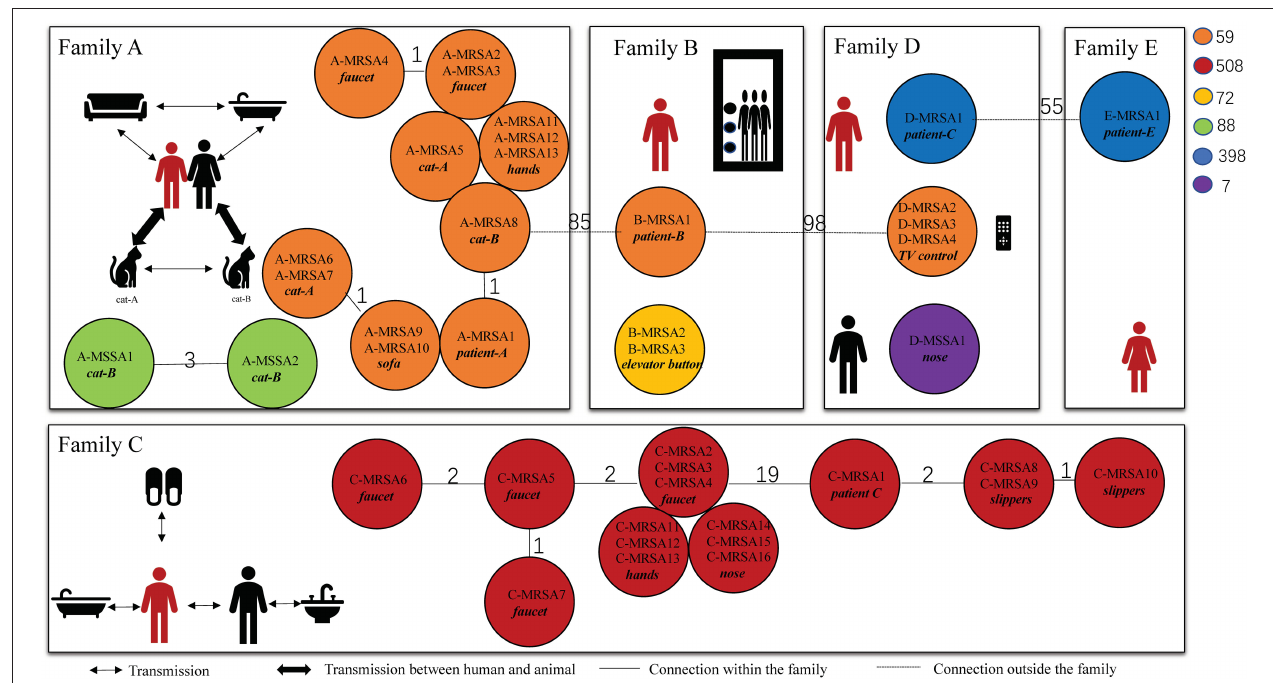
FIGURE 2 | Transmission pattern suggested by core genome multilocus sequence typing of methicillin-resistant Staphylococcus aureus . These isolates were collected from the five patients and their households. The persons in red are patients with CA-MRSA infection, and the ones in black are family members. The different-colored circles represent different ST-type CA-MRSA strains. The number on the line between the circles of different colors represents the number of core allele differences between the isolates. The source of specific specimens is shown in Table 3 . CA, community acquired; MRSA, methicillin-resistant Staphylococcus aureus ; ST, sequence type; MSSA, methicillin-susceptible Staphylococcus aureus